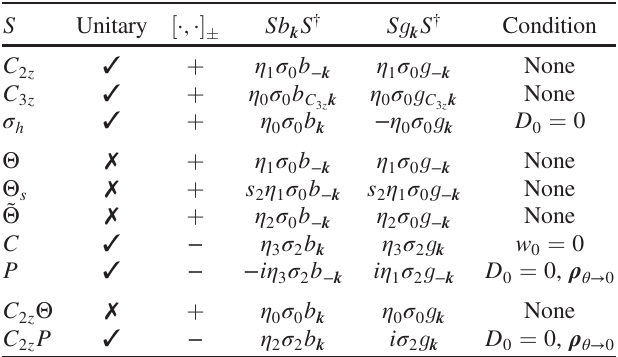
TABLE I. Summary of discrete single-particle symmetries (denoted S ) of our model and when they apply (last